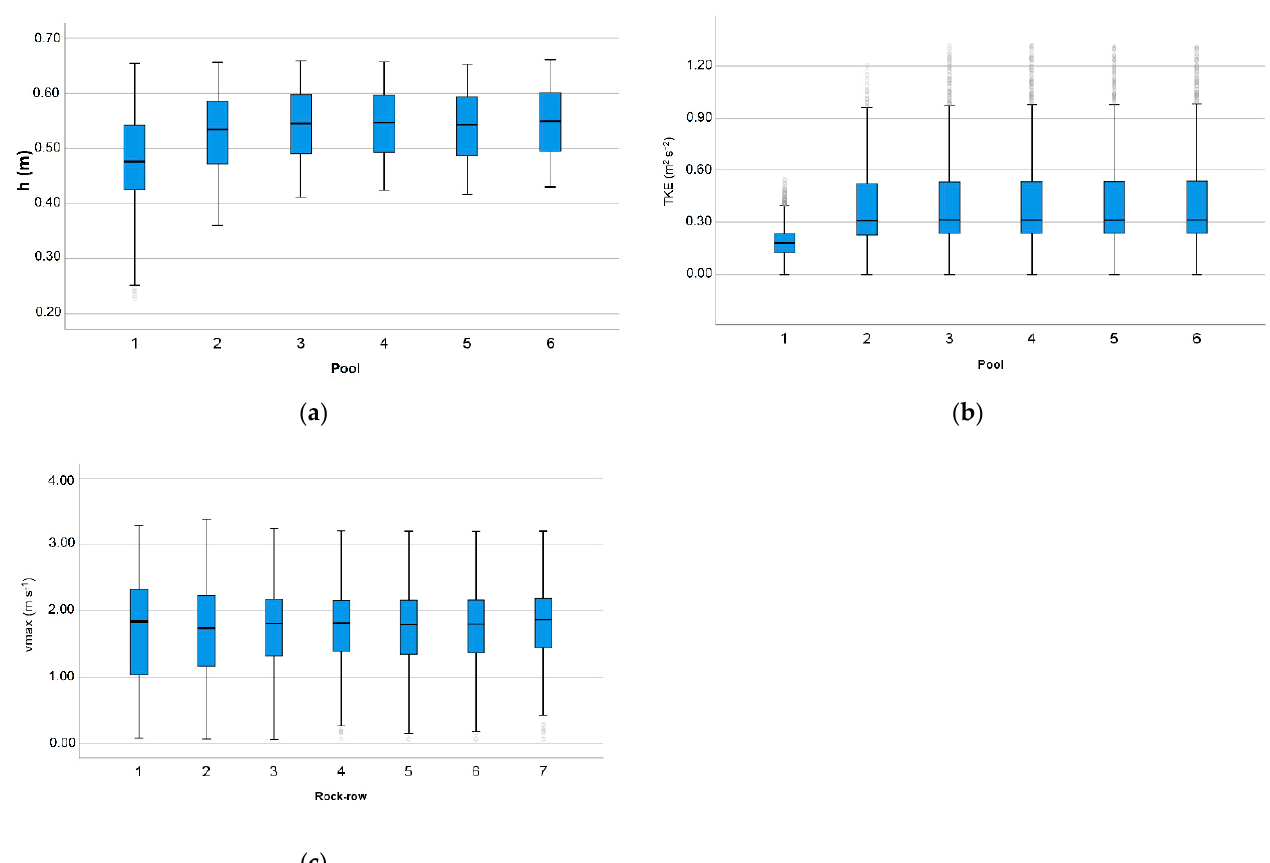
Figure 7. Boxplot of ensemble results of numerical simulation for rectangular boulder layout (R3). ( a ) water depth; ( b ) turbulent kinetic energy; and ( c ) maximum velocity in flow gaps. The boxplot represents the minimum, maximum, median, first quartile (25th percentile), third quartile (75th percentile) and outliers.